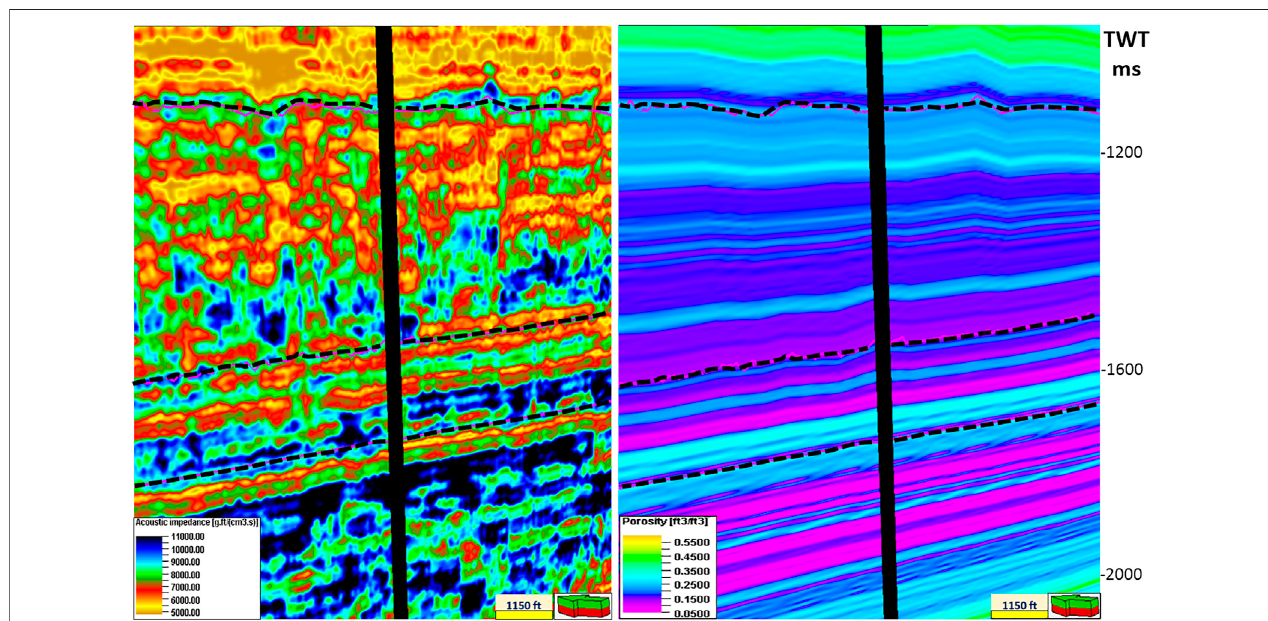
FIGURE 10 | Zooming in for the acoustic impedance and the extrapolated porosity (see Figure 11 ).